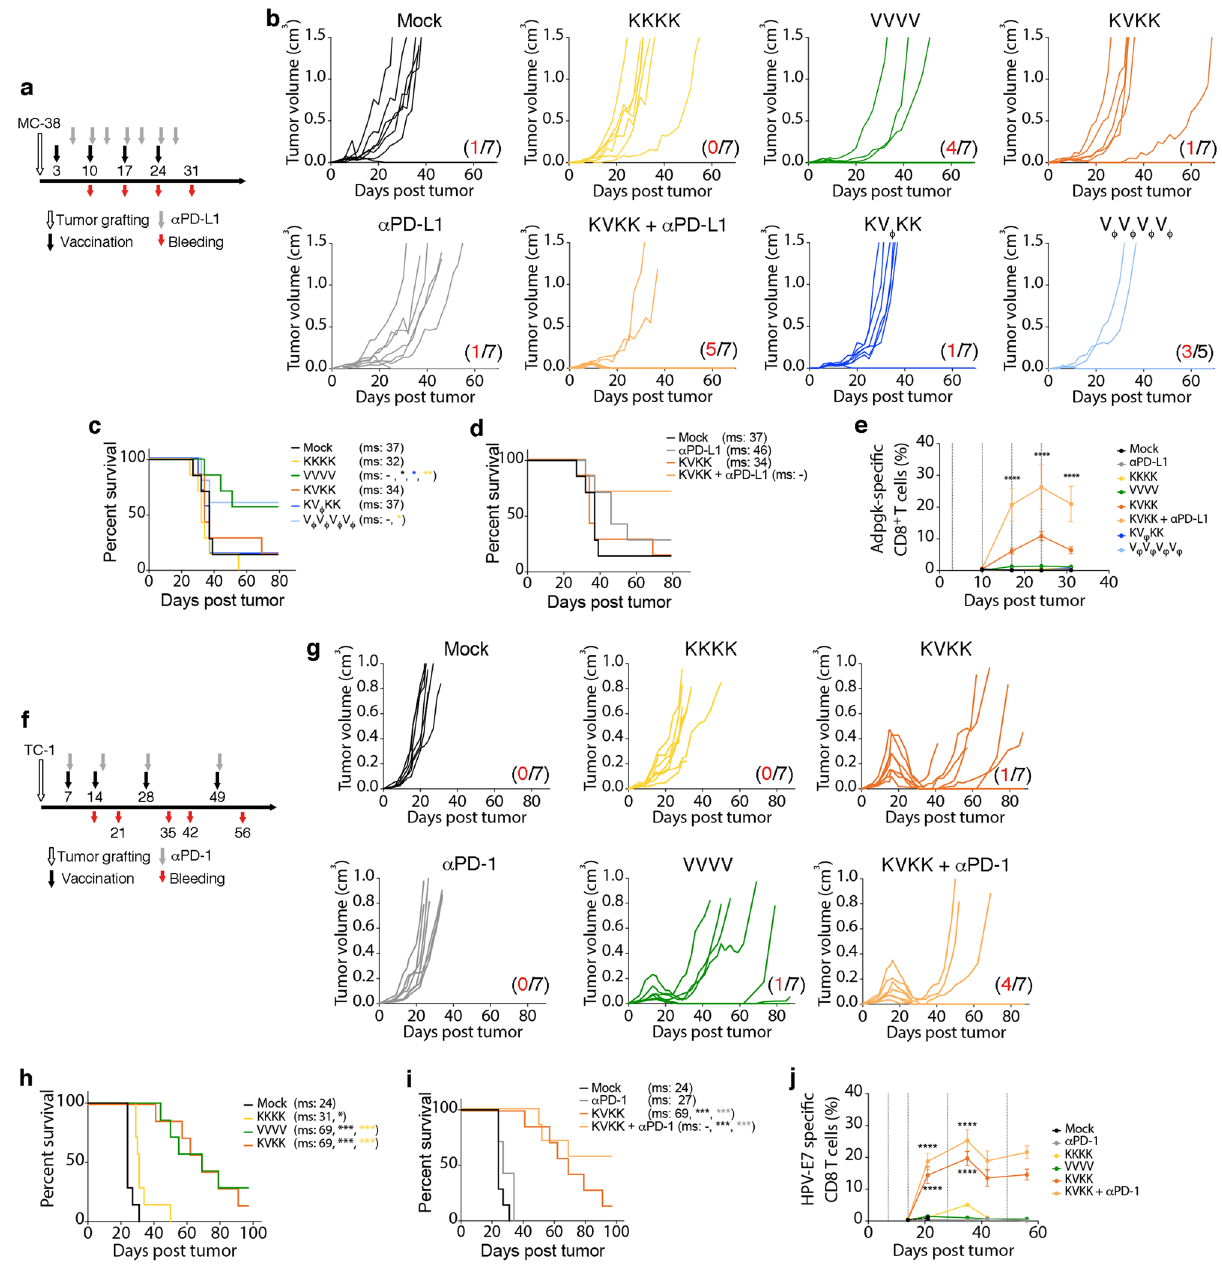
Fig. 6 Ef fi cacy of therapeutic cancer vaccination using KISIMA-TAA and VSV-GP-TAA in syngeneic tumor models targeting neo-epitopes and viral oncoprotein. C57BL/6J mice were subcutaneously injected with ( a – e ) MC-38 cells or ( f – j ) TC-1 cells. Mice were immunized with ( a – e ) KISIMA-Mad24 or VSV-GP-Mad24 or ( f – j ) KISIMA-HPV or VSV-GP-HPV on days indicated in the schematic ( a , f ), respectively. Additionally, mice received 200 µ g of ( a – e ) α PD-L1 antibody i.p. or ( f – j ) α PD-1 antibody i.v. as indicated in the schematic ( a , f ), respectively. b , g Tumor growth curves and ( c , d , h , i ) survival of the animals is depicted with red numbers indicating long-term remissions within a group. Pairwise Log-rank test was performed (* p < 0.05; ** p < 0.01; *** p < 0.001). e , j The frequency of circulating ( e ) Adpgk-speci fi c or ( j ) HPV-E7-speci fi c CD8 + T cells is depicted as mean ± SEM. 5 – 7 mice analyzed per treatment group as indicated in ( b , g ). One-way ANOVA with Tukey ’ s multiple comparison was performed and signi fi cance displayed only for